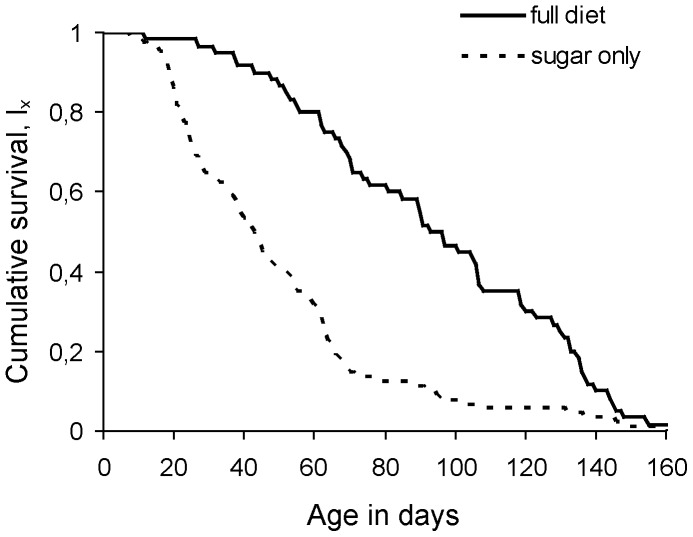
Survivorship of control females fed a full (continuous line) and a protein-deprived (dotted line) diet.Control females were not given the opportunity to mate and were kept virgin throughout lifespan.